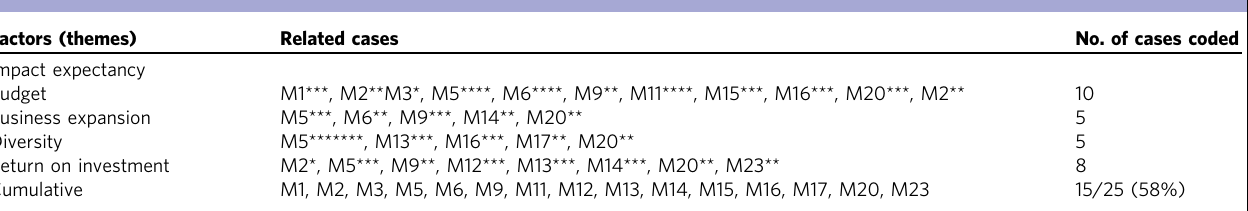
Table 8 Impact of expectancy factors and supported